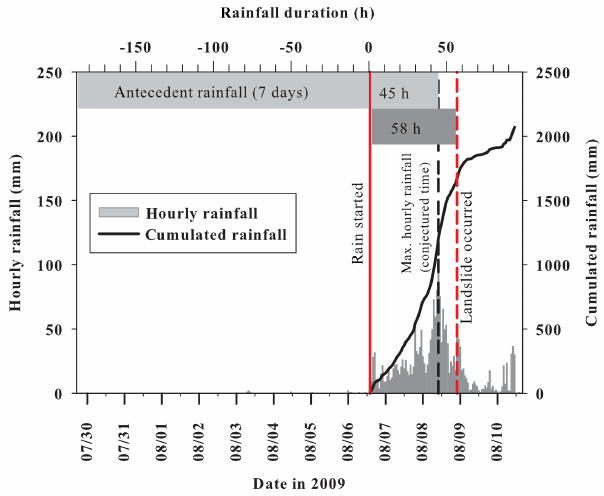
Figure 1. Time series of hourly rainfall and cumulative rainfall from 29 July to 10 August 2009. Rainfall data were collected from the Central Weather Bureau (CWB) C0V250 rainfall gauge station, which is 12km from the Xiaolin landslide. The Xiaolin landslide occurred at 22:16UTC on 8 August 2009. The rainfall event in- duced by Typhoon Morakot in 2009 started at 14:00UTC on 6 Au- gust when hourly rainfall exceeded 4mm. The maximum hourly rainfall was at 10:00UTC on 8 August. In general, if the exact time of landslide occurrence cannot be investigated, the time point with the maximum hourly rainfall will be conjectured as the time of the landslide (Chen et al.,